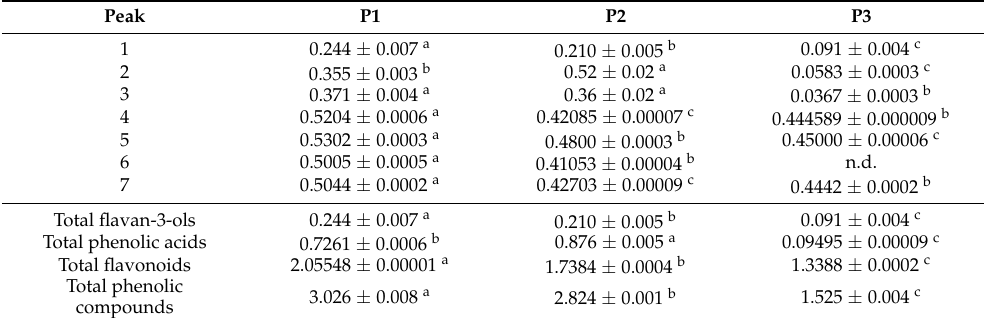
Table 12. Quantification of the phenolic compounds detected under the optimal conditions for each extract (mg/g of extract).